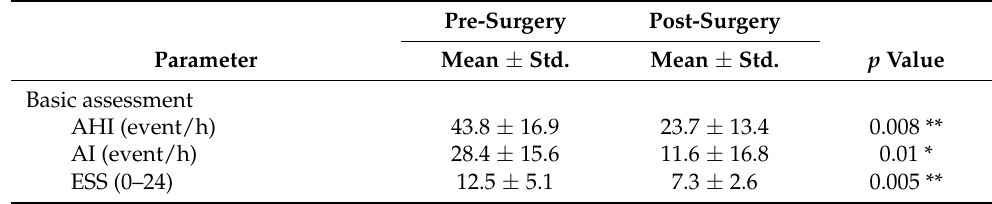
Table 2. Changes in the parameters after